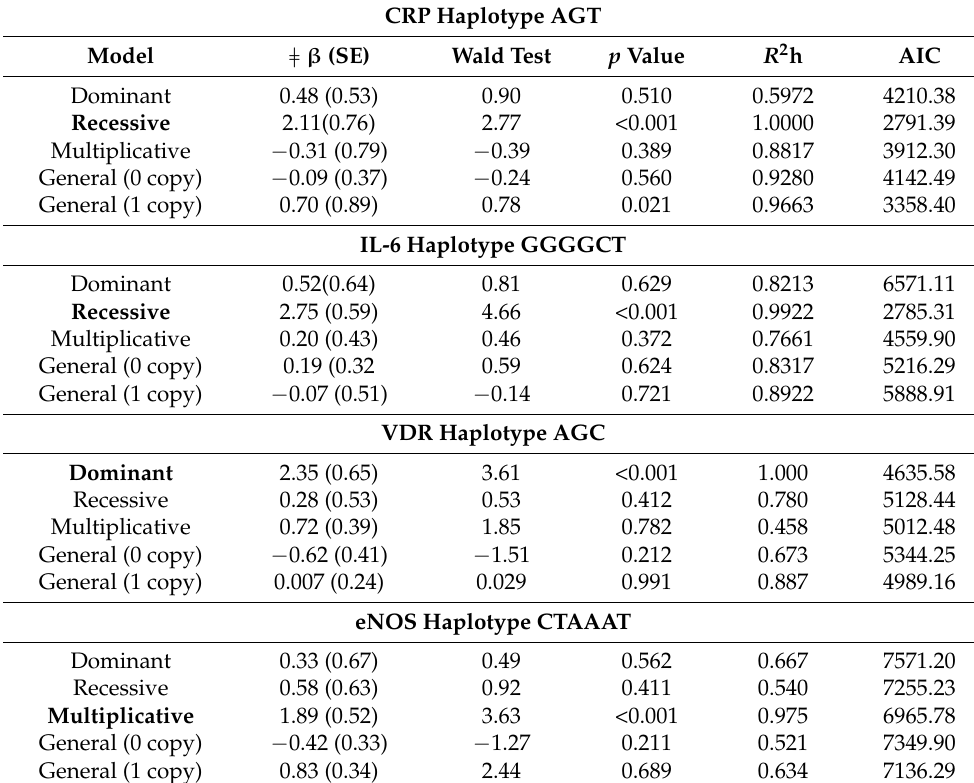
Table 5. Functional implications of susceptibility haplotypes and their best fit model.